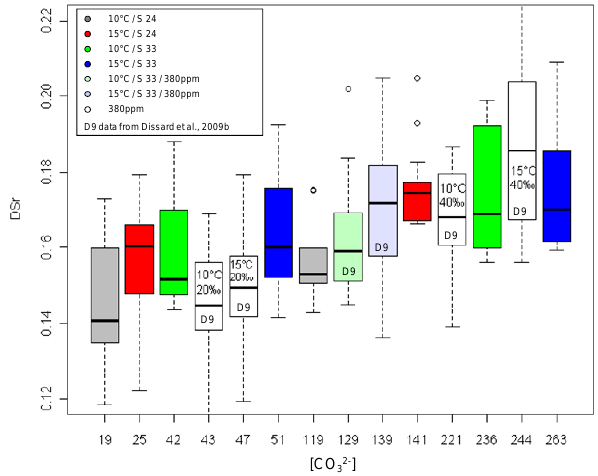
Fig. 6. Sr distribution coefficient (D(Sr)) versus [CO 2 − (µmolkg − 1 ) at 10 ◦ C, salinity 24 (grey); 15 ◦ C, salinity 24 (red); 10 ◦ C, salinity 33 (green); and 15 ◦ C, salinity 33 (blue); at 10 ◦ C, salinity 33, 380ppmv (pale green); 15 ◦ C, salinity 33, 380ppmv (pale blue); 10 ◦ C, salinity 20, 380ppmv; 15 ◦ C salin- ity 20, 380ppmv; 10 ◦ C, salinity 40, 380ppmv, and 15 ◦ C salin- ity 40, 380ppmv (white). Data for ambient atmospheric conditions (380ppmv, labelled D9) are from Dissard et al. (2009b). The first to third quartile (box), range (dotted line) and median (thick line) are shown for each